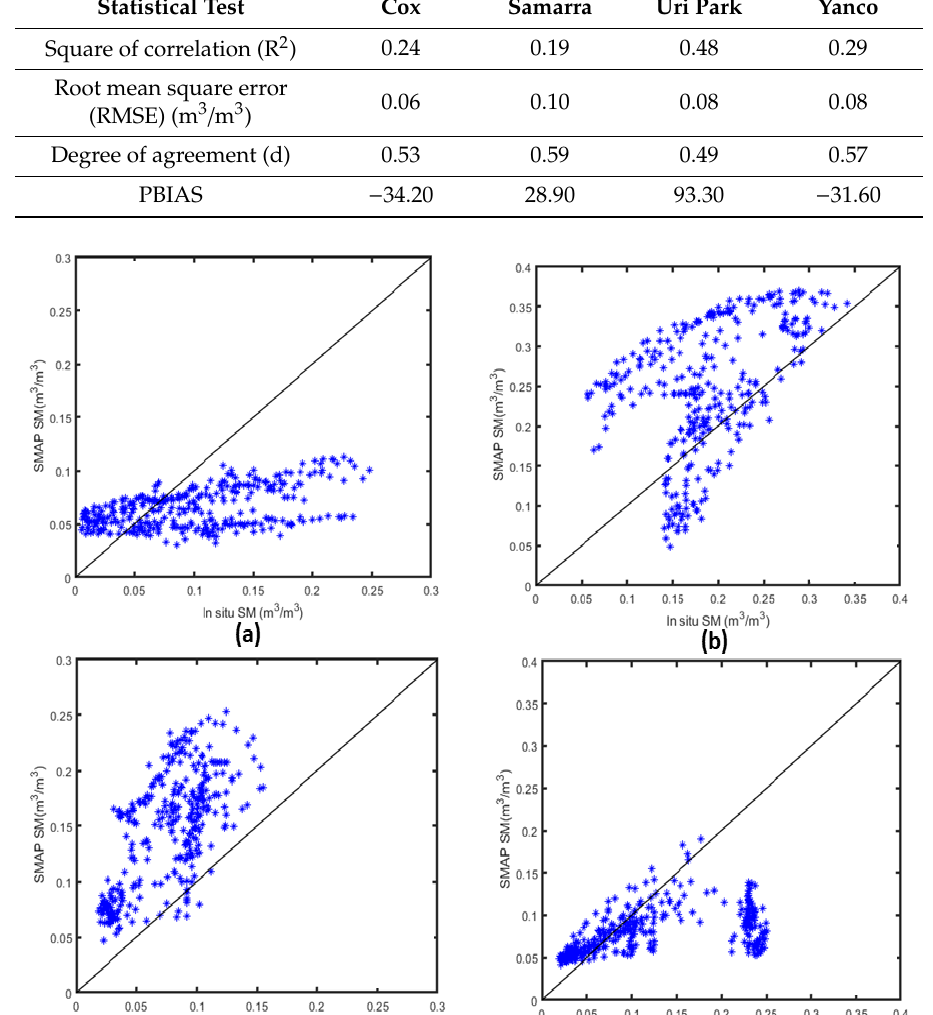
Table 6. Results of comparison between the in situ and SMAP data set at selected site of Australia. Statistical Test Cox Samarra Uri Park Yanco Square of correlation (R 2 ) 0.24 0.19 0.48 0.29 Root mean square error (RMSE) (m 3 / m 3 )